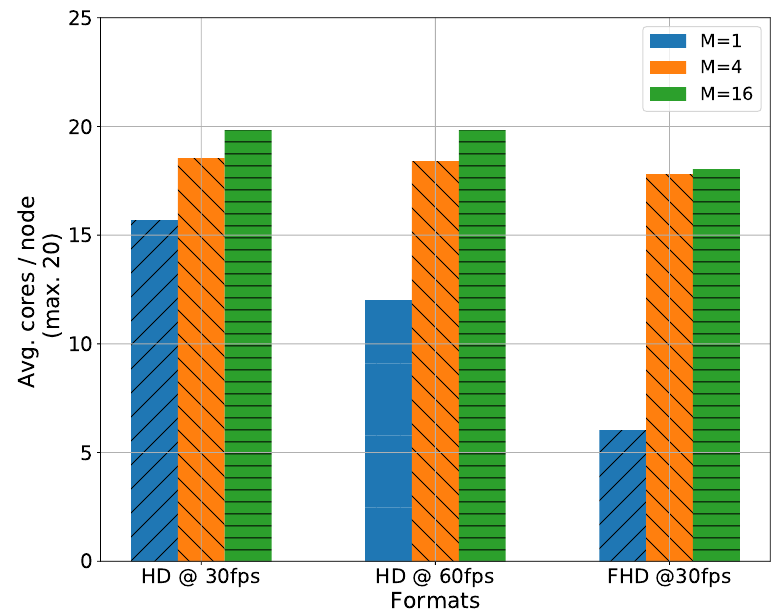
Figure 7. Impact of media formats on resource utilization for different M